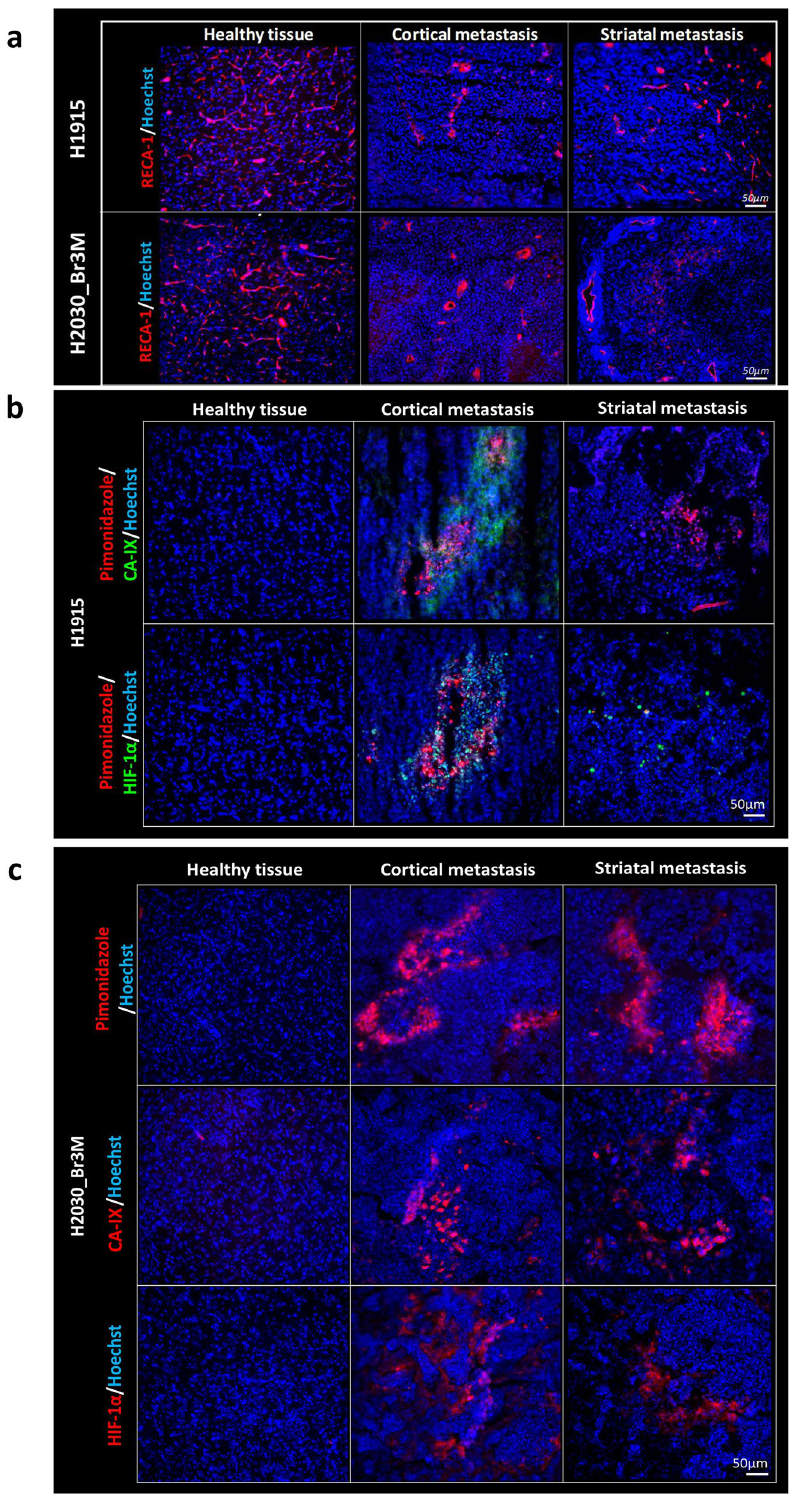
Figure 3. Immunohistochemical studies of vascularization and hypoxia in BM. ( a ) Representative images of RECA immunostaining (vascularization , red) with a Hoechst 33342 nuclear counterstaining (blue) for H1915 and H2030-Br3M models. ( b ) Representative images of pimonidazole staining (red), CA-IX staining (green, top row) and HIF-1α staining (green, bottom row) with a Hoechst 33,342 nuclear counterstain (blue) in the BM model from human lung adenocarcinoma (H1915, cortical and striatal metastasis) and healthy tissues. ( c ) Representative images of pimonidazole staining (red-top row), CA-IX staining (red-middle row) and HIF-1α (red-bottom row) with a Hoechst 33342 nuclear counterstain (blue) on BM model from human lung adenocarcinoma (H2030-Br3M, cortical and striatal metastasis) and healthy